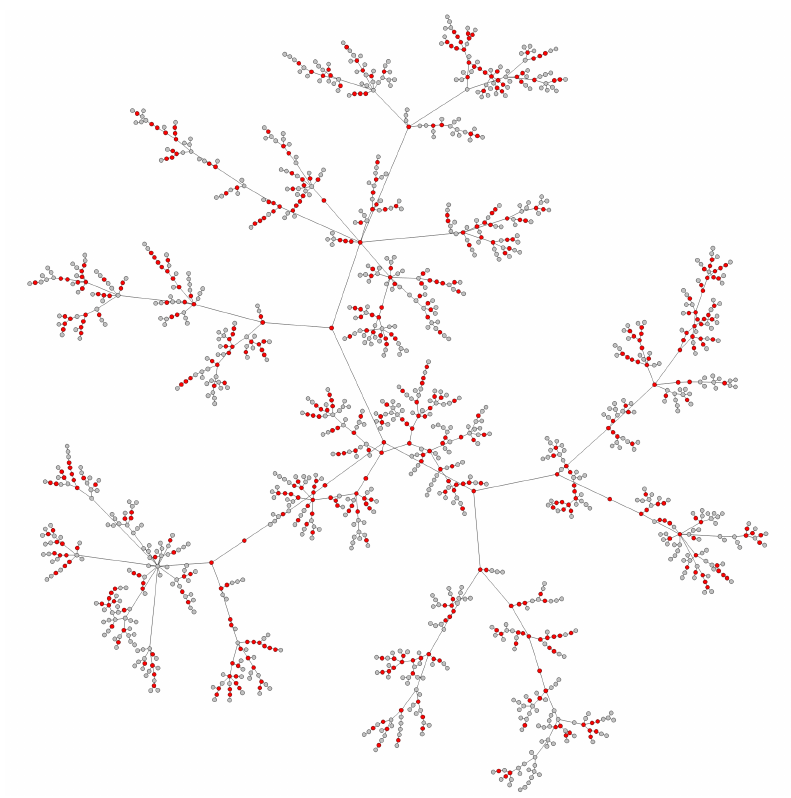
Figure A1. The inferred Canada transmission